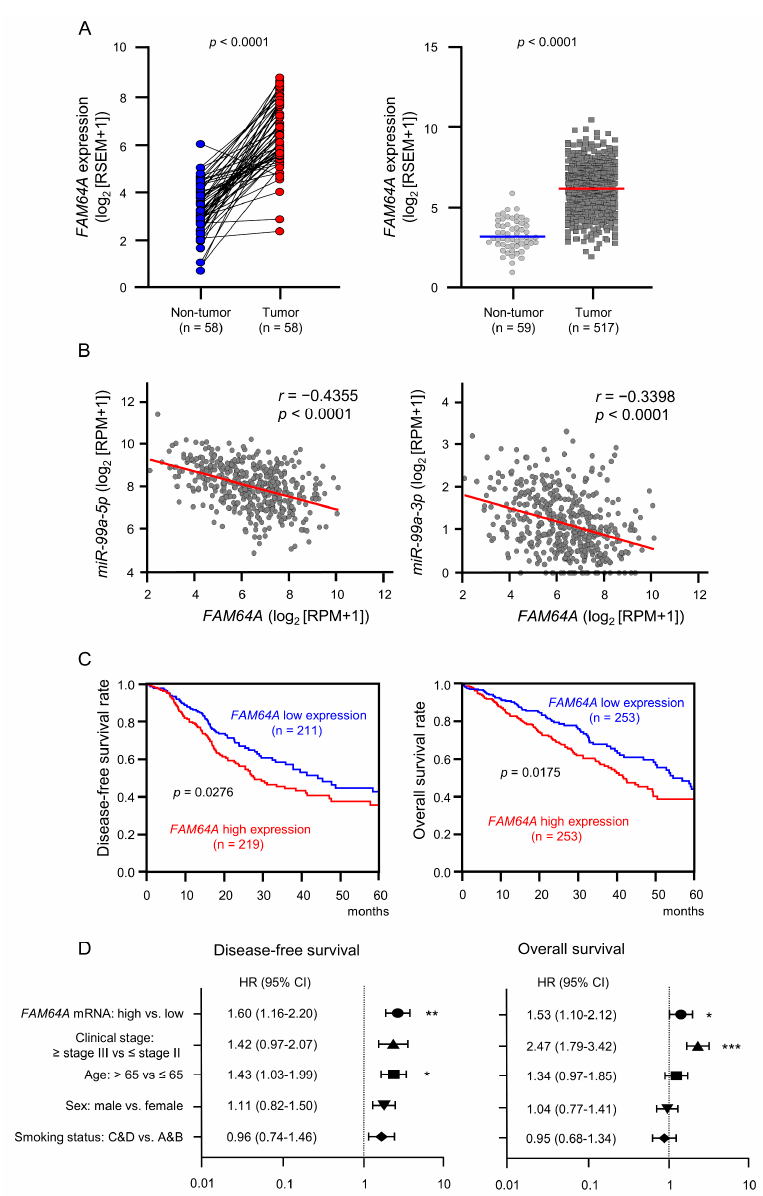
Figure 7. Clinical significance of FAM64A expression in LUAD. ( A ) Comparison of FAM64A expression levels between tumor and non-tumor tissues in paired (left) and non-paired (right) LUAD clinical specimens from TCGA datasets. Upregulation of FAM64A was detected in LUAD tissues. ( B ) Correlations between the relative expression level of FAM64A and that of miR-99a-5p or miR-99a-3p . Spearman’s rank test showed a negative correlation between FAM64A and miR-99a-5p or miR-99a-3p expression levels in clinical specimens. ( C ) Kaplan–Meier survival curves and log-rank comparisons of patients with LUAD using TCGA database. Patients were divided into two groups according to the median FAM64A expression level: high and low expression groups. The red and blue lines represent the high and low expression groups, respectively. ( D ) Forest plot of the multivariate analysis results assessing independent prognostic factors for disease-free and overall survival, including FAM64A expression (high vs. low) (* p < 0.05, ** p < 0.01, *** p <